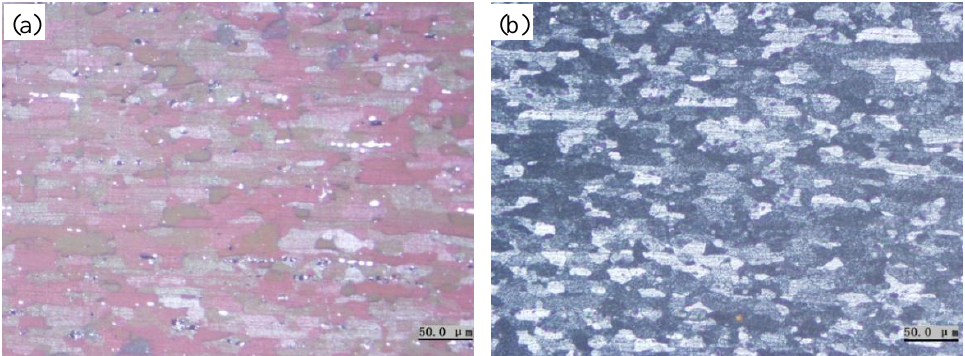
Figure 4. The grains of 5083 aluminum alloy sheets in two heat treatments: ( a ) annealed and ( b ) quenched.